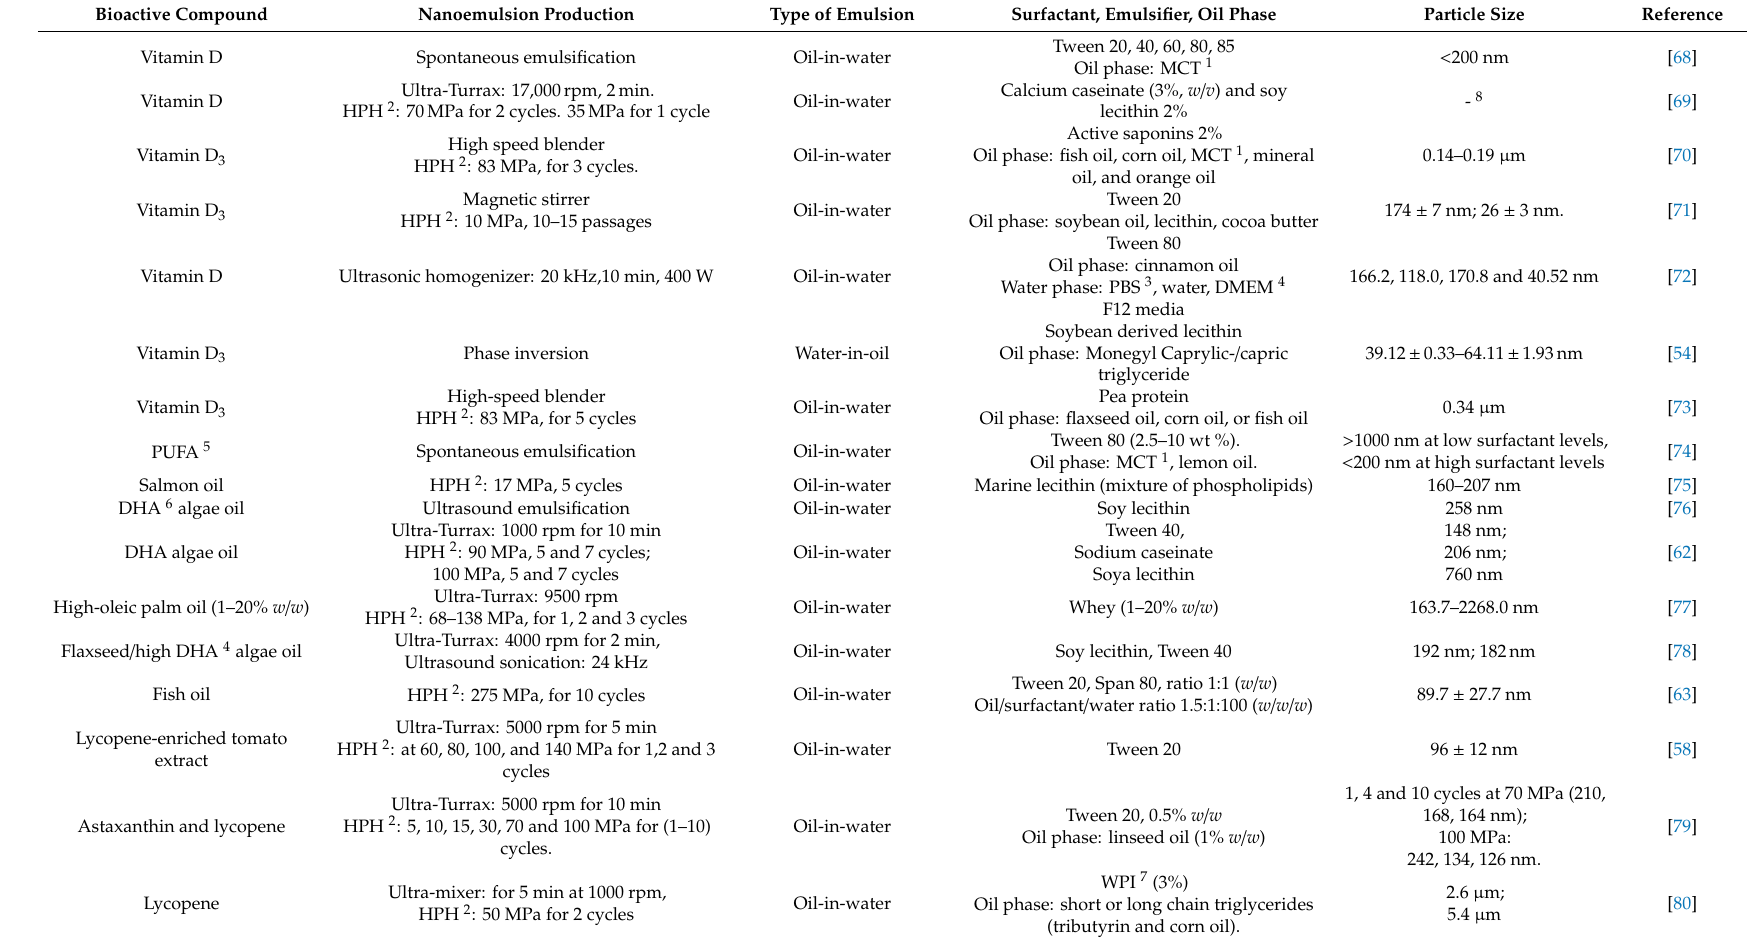
Table 2. Application of nanoemulsions for encapsulation of lipid-soluble